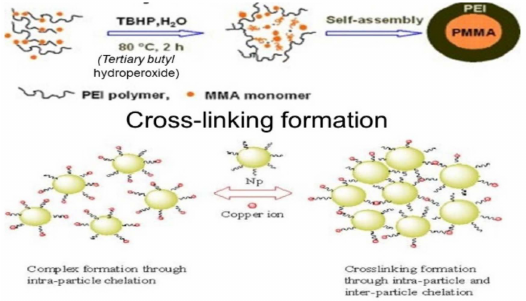
Figure 2. Synthesis route to PEI/PMMA composites.